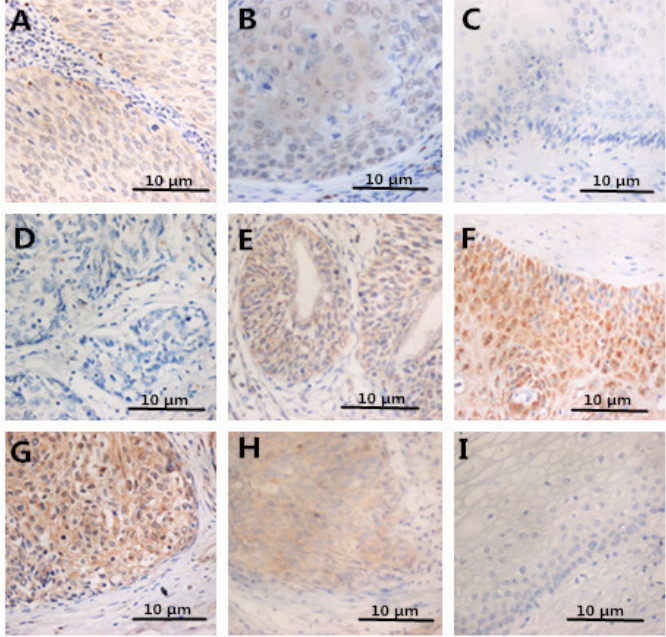
Figure 3. Immunohistochemical staining of FOXP3 in cervical samples ( A – C ); staining